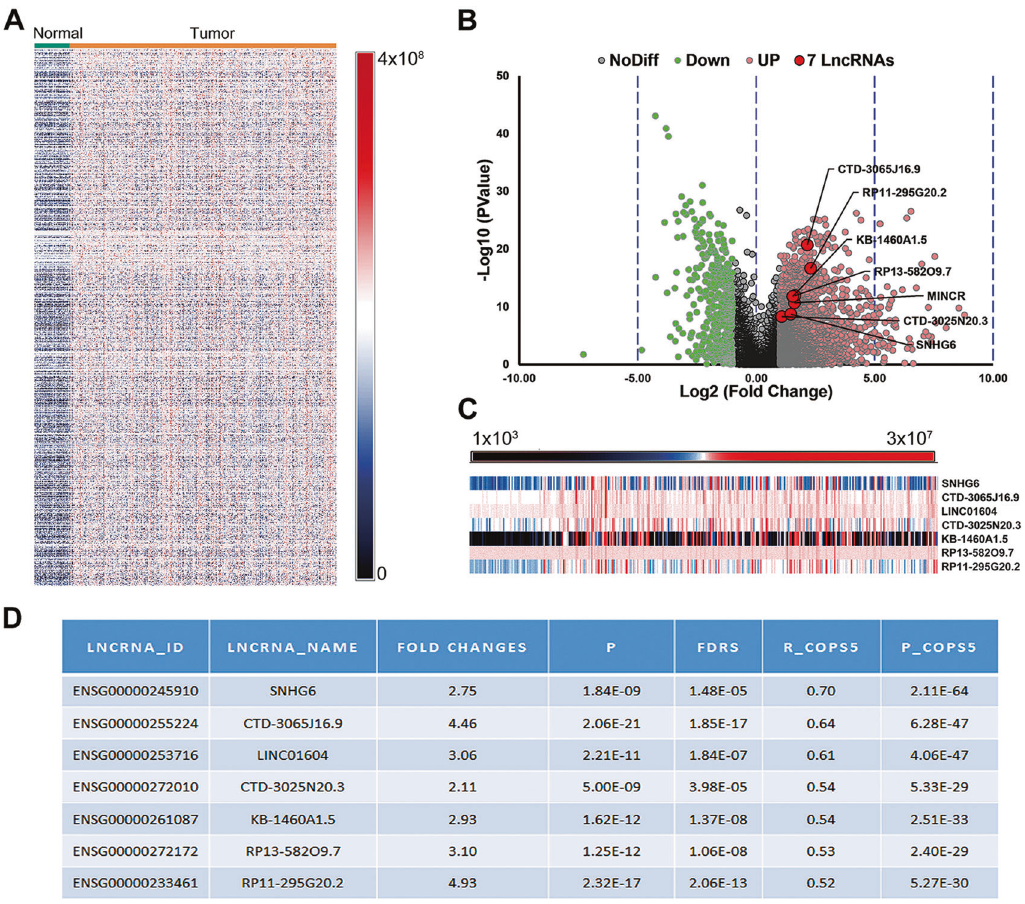
Fig. 2 Differentially expressed lncRNAs in HCC from the TCGA database. A Heatmap of 1031 upregulated lncRNAs in 371 HCC tissues compared with 50 normal tissues B Volcano plot showed the distribution of the seven-lncRNA differential expression, which positively correlated with CSN5 co-expression between HCC and adjacent normal tissues (No Diff no difference, UP upregulation, Down downregulation). C Heatmap for the seven-lncRNA expression pro fi les. D Table presented the relative fold changes of lncRNAs in HCC, compared to normal samples, and the correlation coef fi cients with CSN5